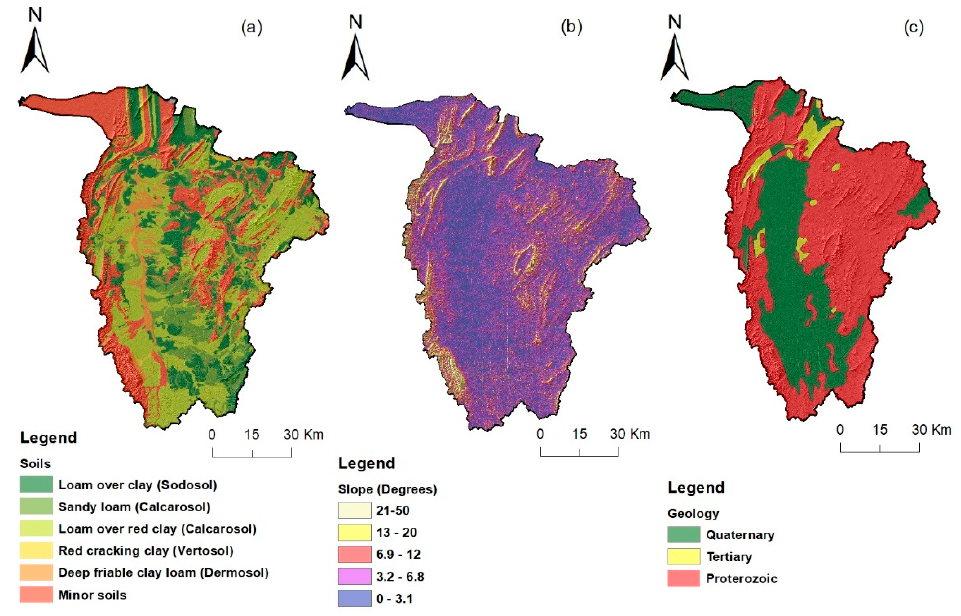
Figure 7. The thematic layers of soil, slope, and